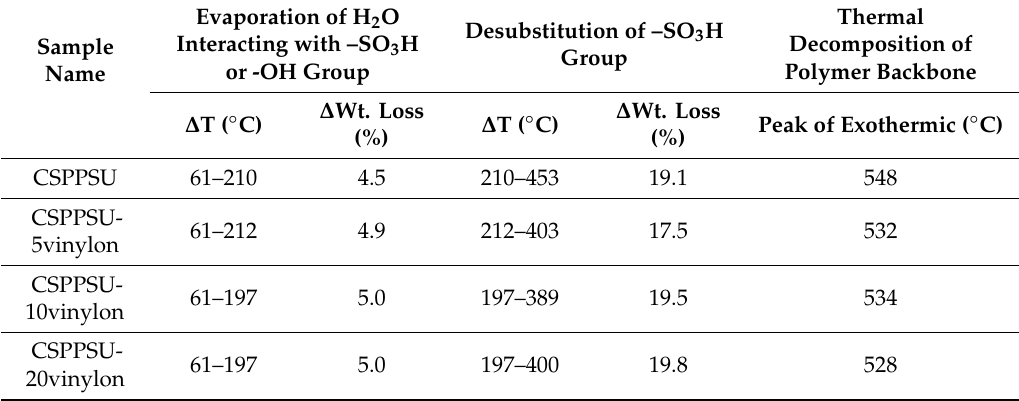
Stress-strain properties of ( a ) CSPPSU-5vinylon, ( b ) CSPPSU-10vinylon, ( c ) CSPPSU-20vinylon, and ( d ) CSPPSU membranes. Table 3. Summary of temperature ranges and mass losses observed for each step in the TG-DTA curves for CSPPSU-vinylon Table 4. Mechanical properties of CSPPSU-vinylon membranes.